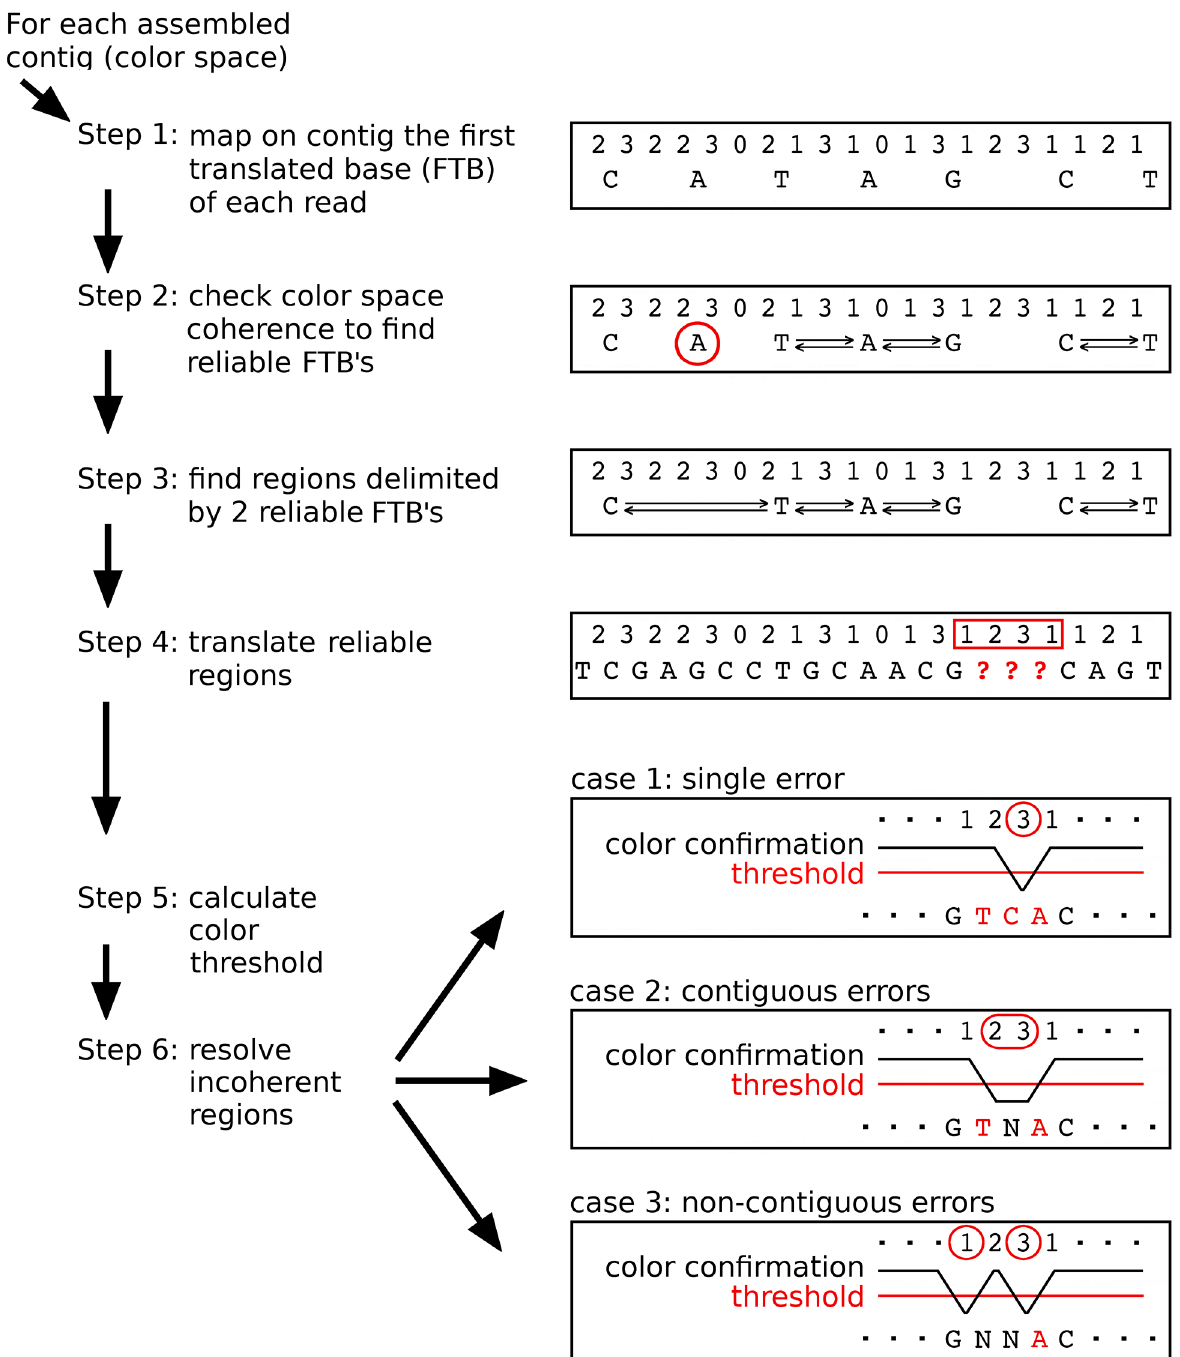
Fig 1. Flowchart of the color-translation process. Step1: the first base (FTB) of each read can be translated from color-space with high accuracy; for each read the FTB is mapped on the contig. Step 2: check color coherence with neighboring FTBs; three conditions can be detected: a) FTBs coherent with their neighboring FTBs on both sides (such as the 'A' at the centre of the figure); FTB coherent only on one side (such as the 'G' that is coherent with the 'A', but not with the 'C'); FTBs with no coherence on both sides (such as the 'A' circled in red). The latter are removed from the assembly. Step 3 and 4: find regions delimited by two reliable start sites and translate color-space into base-space. Any remaining regions will be incoherent in terms of color compatibility. To resolve these regions the threshold for color reliability is calculated (Step 5) and the resulting value is used to establish the critical regions of the contig (Step